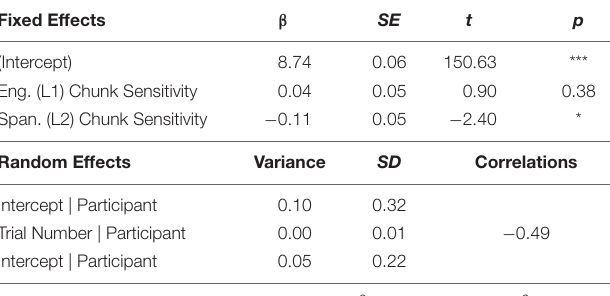
TABLE 6 | Summary of model output for reading times of the